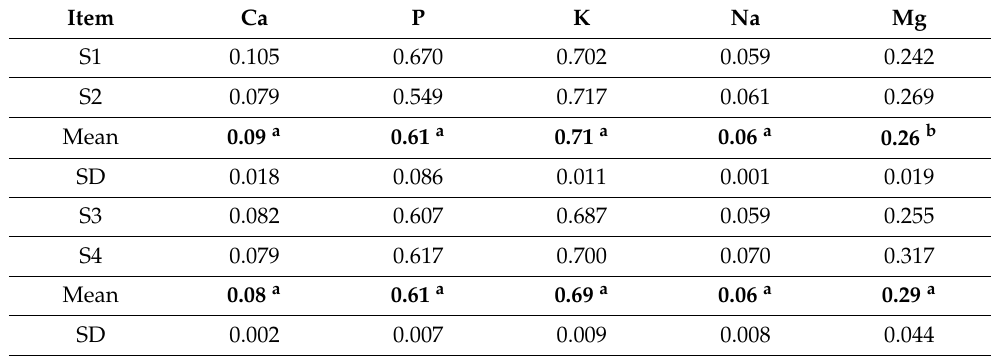
Table 4. Macromineral (g/100 g DM) content of extruded (S1, S2) and baked (S3, S4) dog